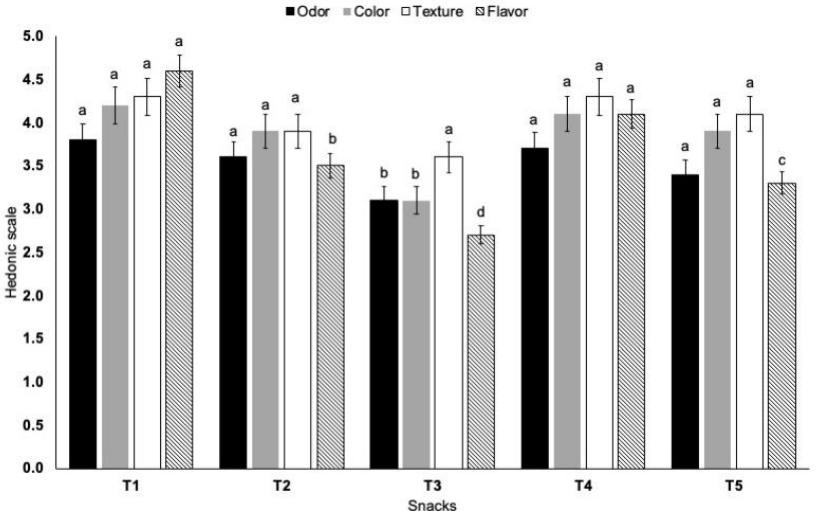
Figure 1. Sensory evaluation of 100% cornmeal snacks (T1), 80% cornmeal–20% umbrella snacks (T2), 50% cornmeal–50% umbrella snacks (T3), 80% cornmeal–20% oral arms snacks (T4), and 50% cornmeal–50% oral arms snacks (T5). Different letters among snacks for each sensory attribute are statistically different ( p < 0.05).